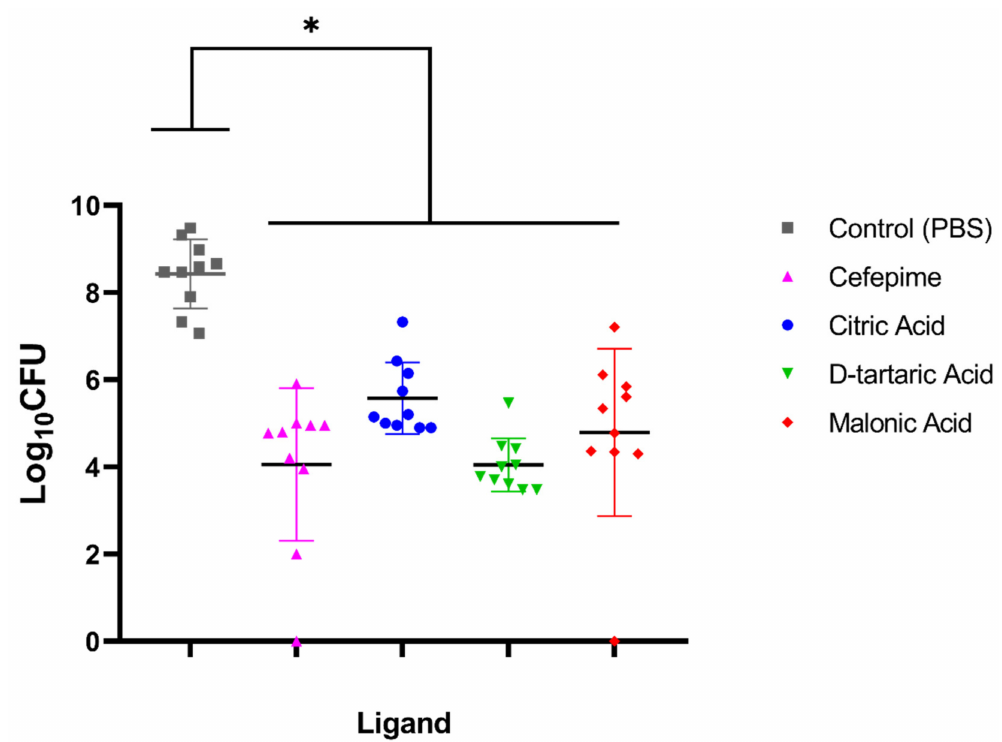
Figure 7. The antibacterial activity of citric acid, D-tartaric acid and malonic acid in comparison to cefepime and the control (PBS) against A. baumannii ATCC 19606 in a skin wound infection in the mouse model. Data are represented by the mean colony counts obtained from each of the five infected groups ( n = 10 mice in each group) ± SD after six days of treatment. Statistical analysis was carried out using GraphPad, applying a one-way ANOVA followed by Tukey’s multiple comparisons test. (*) denotes a statistical significant difference ( p -value < 0.0001) existing between